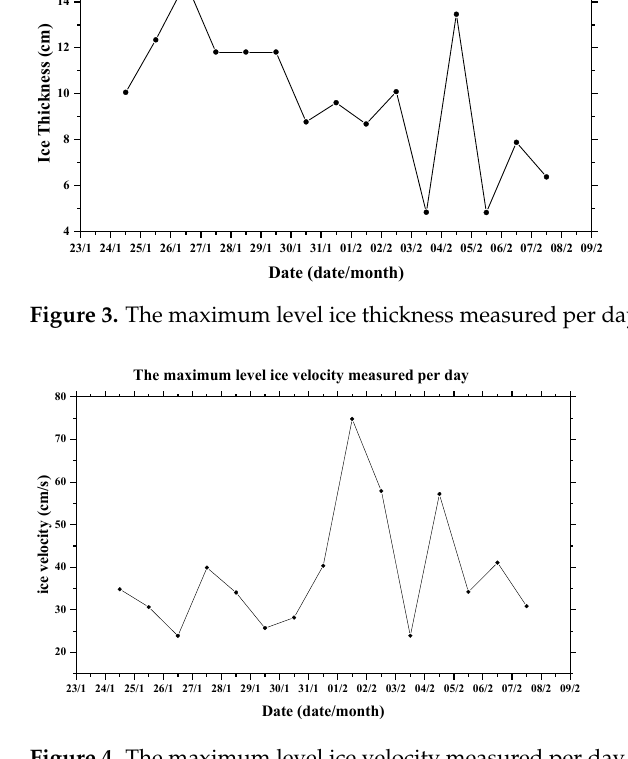
Figure 4. The maximum level ice velocity measured per day in January and February 2018.